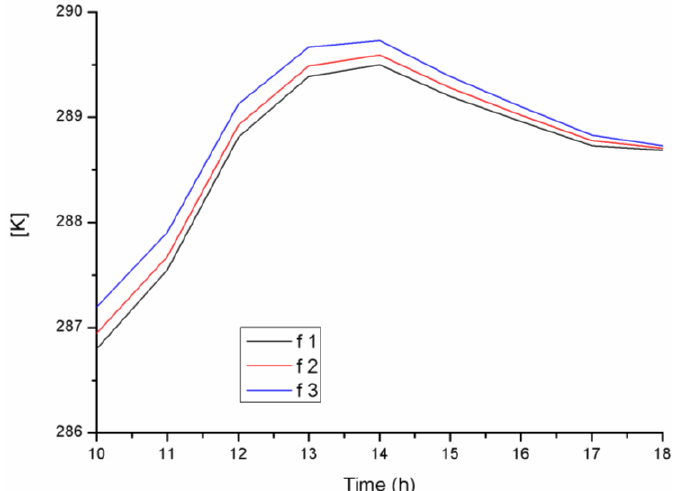
Figure 10. Air outlet temperature is plotted as function of time for different time steps.